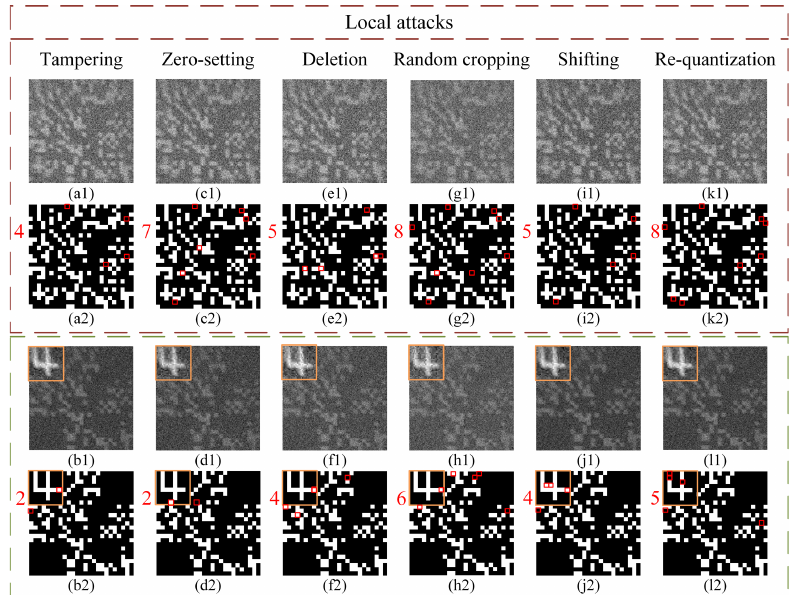
Figure 7. Results under six different kinds of local attacks. ( a1 , a2 , c1 , c2 , e1 , e2 , g1 , g2 , i1 , i2 , k1 , k2 ) in the brown dotted box and ( b1 , b2 , d1 , d2 , f1 , f2 , h1 , h2 , j1 , j2 , l1 , l2 ) in the green dotted box are the recovered ghost images and their binarized results obtained using the interactive superposed CKD protocol and the proposed protocol under six different types of local attacks: tampering, zero-setting, deletion, random cropping, shifting and re-quantization,